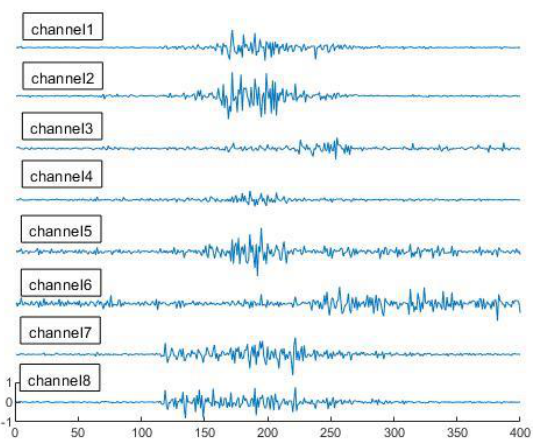
Figure 3. Original surface electromyography (sEMG) signals recorded by the MYO armband.